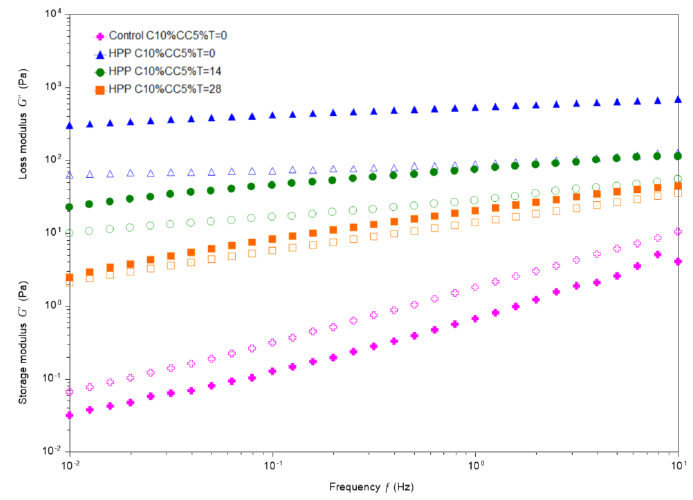
Figure 2. Frequency sweep curves for the control sample and treated samples at different sampling times. Storage modulus (G´): closed symbols; loss modulus (G´´): open symbols. Legend : HPP−High - pressure processing; C10 %CC5 %− Casein 10 %, Cocoa 5 %; T = 0, T = 14, T = 28. Different storage times at time 0,14 days and 28 days.